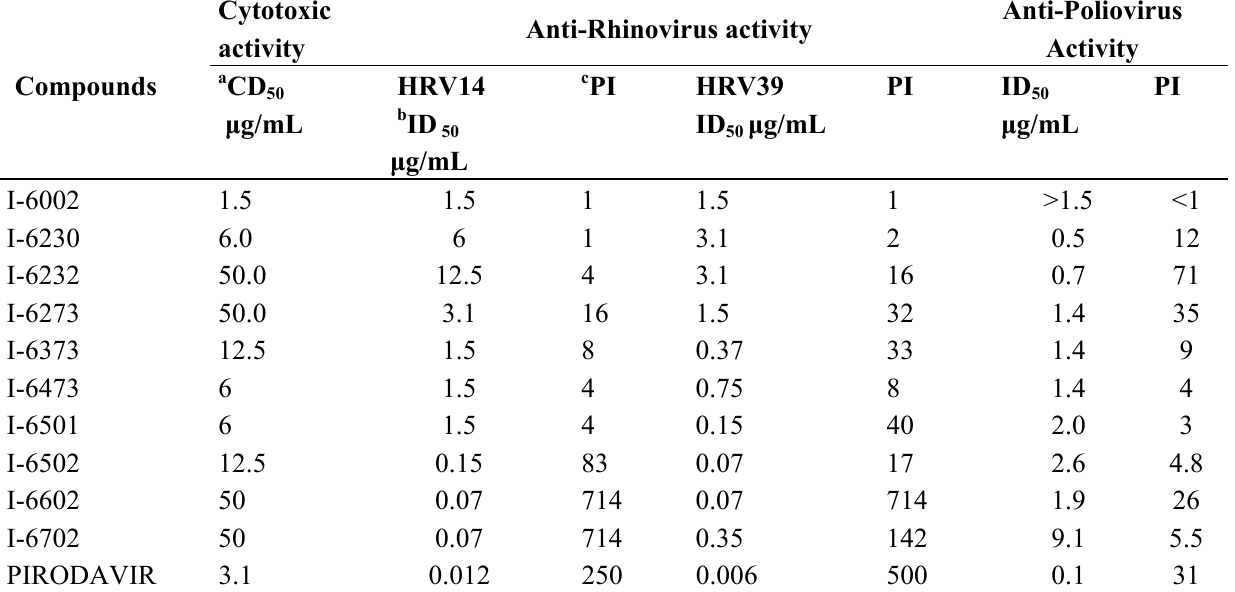
Table 1. Screening of cytotoxic activity and anti-Rhinovirus properties of the novel compounds and the control